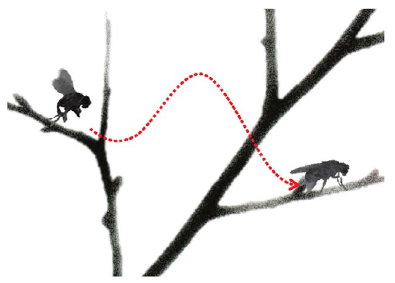
Figure 1. ‘‘Take off’’ and ‘‘landing’’ for fly anesthesia. In this schematic, induction of anesthesia is represented by the fly taking off, with the height of the branch represent- ing the drug dose. ‘‘Landing’’ (or emergence) from anesthesia occurs on a lower branch representing a lower drug dose than ‘‘take off’’. The difference in height between the branches signifies neural inertia, the resistance in changing between anaesthetized and wakeful states. The parts of this figure are adapted from images by Antonia Foy (